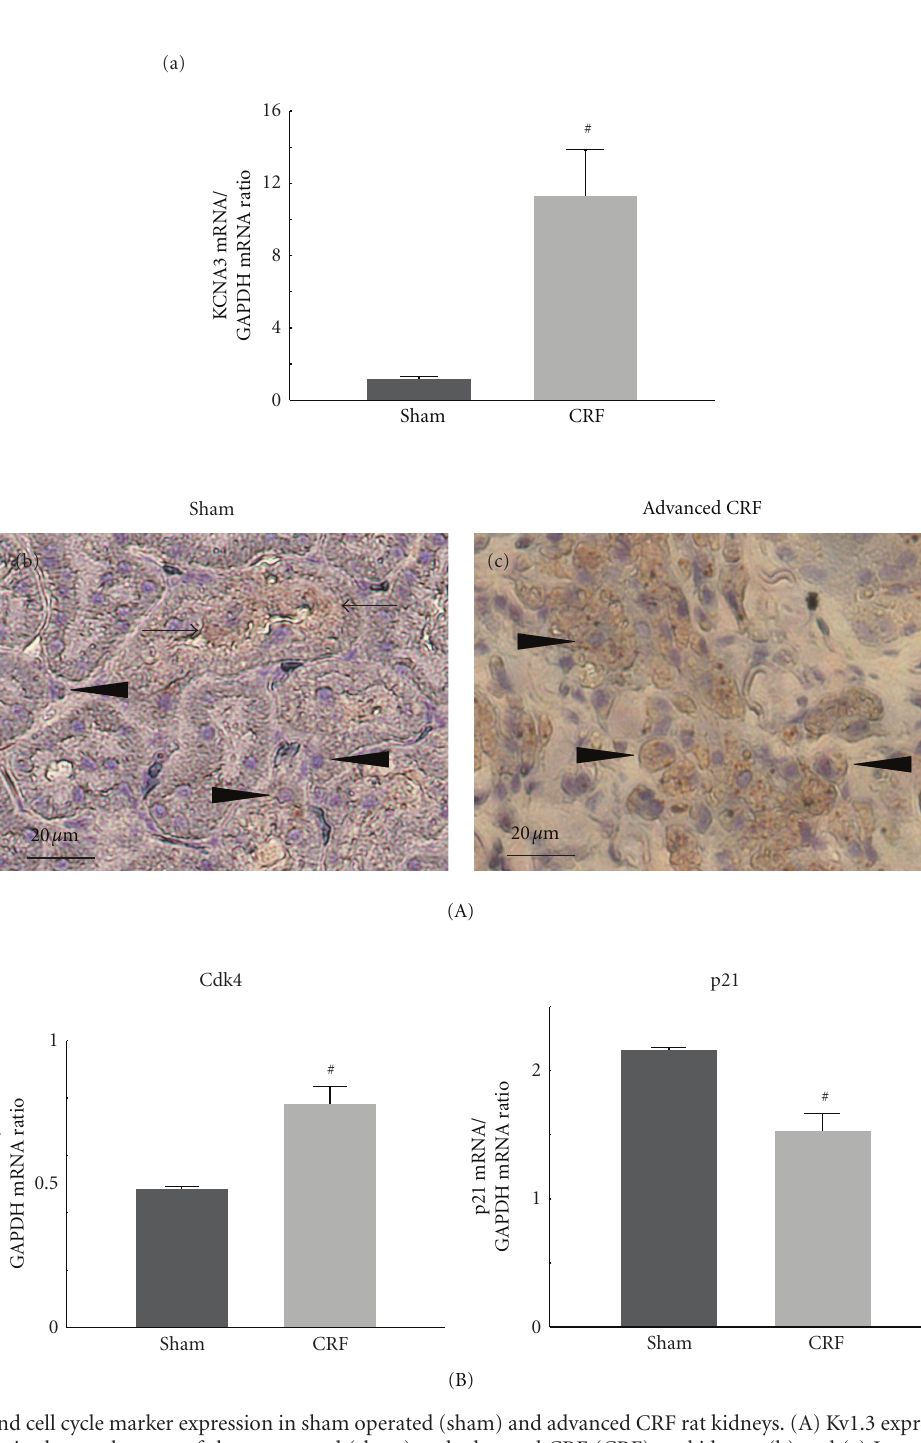
Figure 2: Kv1.3 and cell cycle marker expression in sham operated (sham) and advanced CRF rat kidneys. (A) Kv1.3 expression. (a) KCNA3 mRNA abundance in the renal cortex of sham operated (sham) and advanced CRF (CRF) rat kidneys. (b) and (c) Immunohistochemistry using antibody for Kv1.3 (brown) in sham operated and advanced CRF rat kidneys. High-power views of cortical interstitium. Magnification, × 60. (B) Cell cycle marker expression. The mRNA abundance of cyclin-dependent kinase 4 (Cdk4) (left) and p21 (right) in the renal cortex of sham operated and advanced CRF rat kidneys. # P < 0 . 05 versus sham operated rats. Values are means ± SEM ( n = 6). Di ff erences were analyzed by ANOVA followed by Dunnett’s or Student’s t